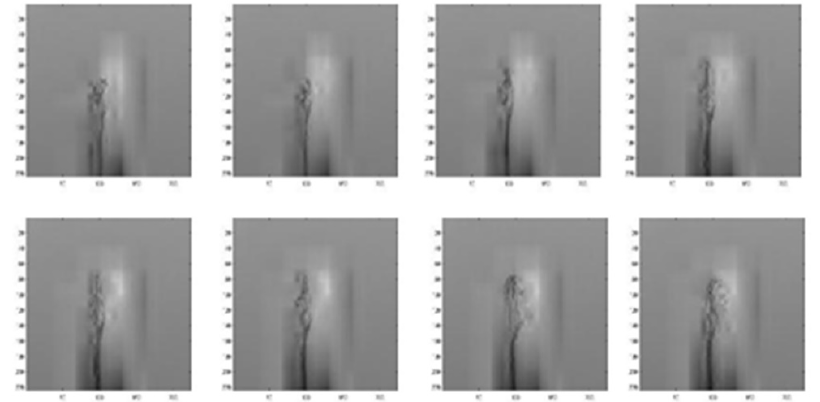
Figure 16. The fused image of two different sensor modalities of “Depth-Grayscale” and “CCD RGB-IR” by wavelet image fusion with max-min operations for VGG-16 CNN deep learning and recognition (e.g., the hand gesture intention action, Action 1).